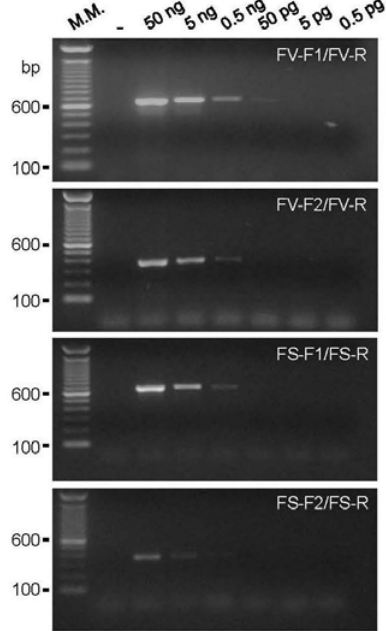
Figure 1. Sensitivity analysis. Electrophoresis on a 1.5% agarose gel stained with ethidium bromide showing the PCR reactions for the genomic DNA of F. verticillioides CML 767 with a 10-fold serial dilution for the FV primer pairs of and from F. subglutinans UnB 379 also with a 10-fold serial dilution for the FS primer pairs. M.M. indicates the 100-bp molecular marker (Invitrogen, USA). The negative sign ( − ) indicates the negative control reaction with no DNA added.